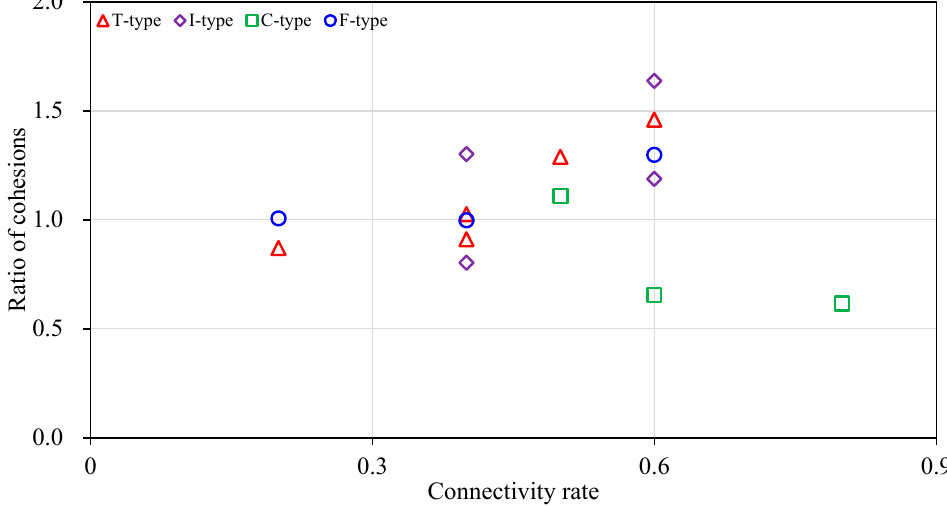
Figure 5. The cohesion ratio of different types of samples.